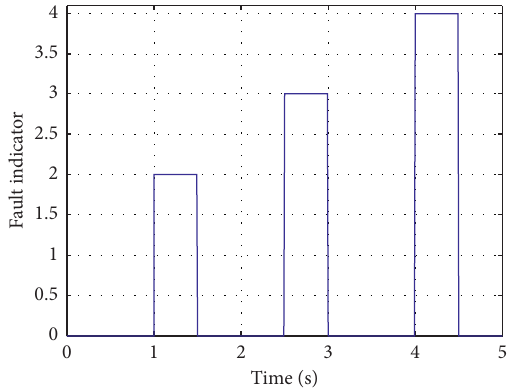
Figure 13: Fault indication output.